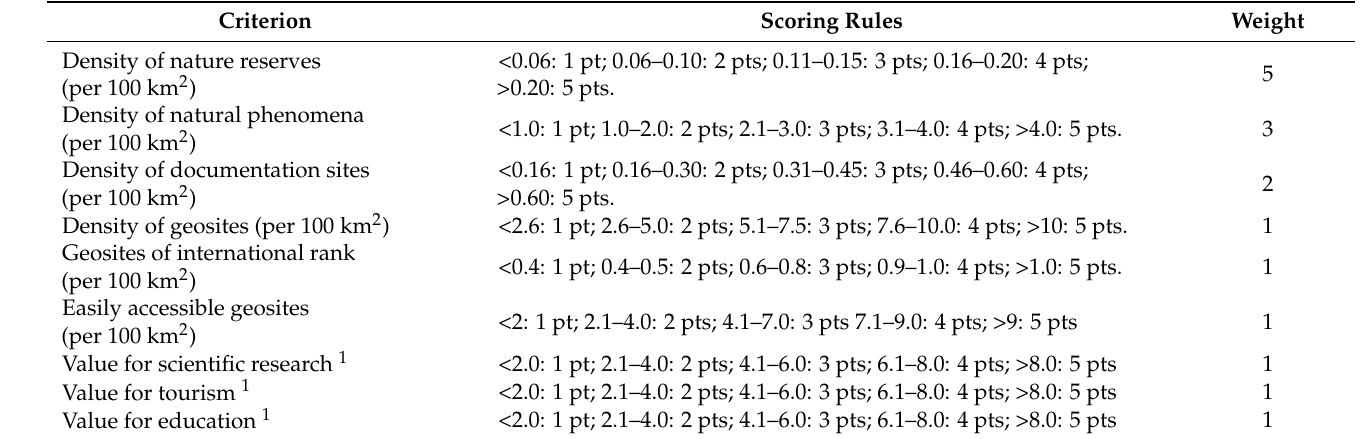
Table 1. The principles of assessing landscape parks according to the presence of abiotic nature